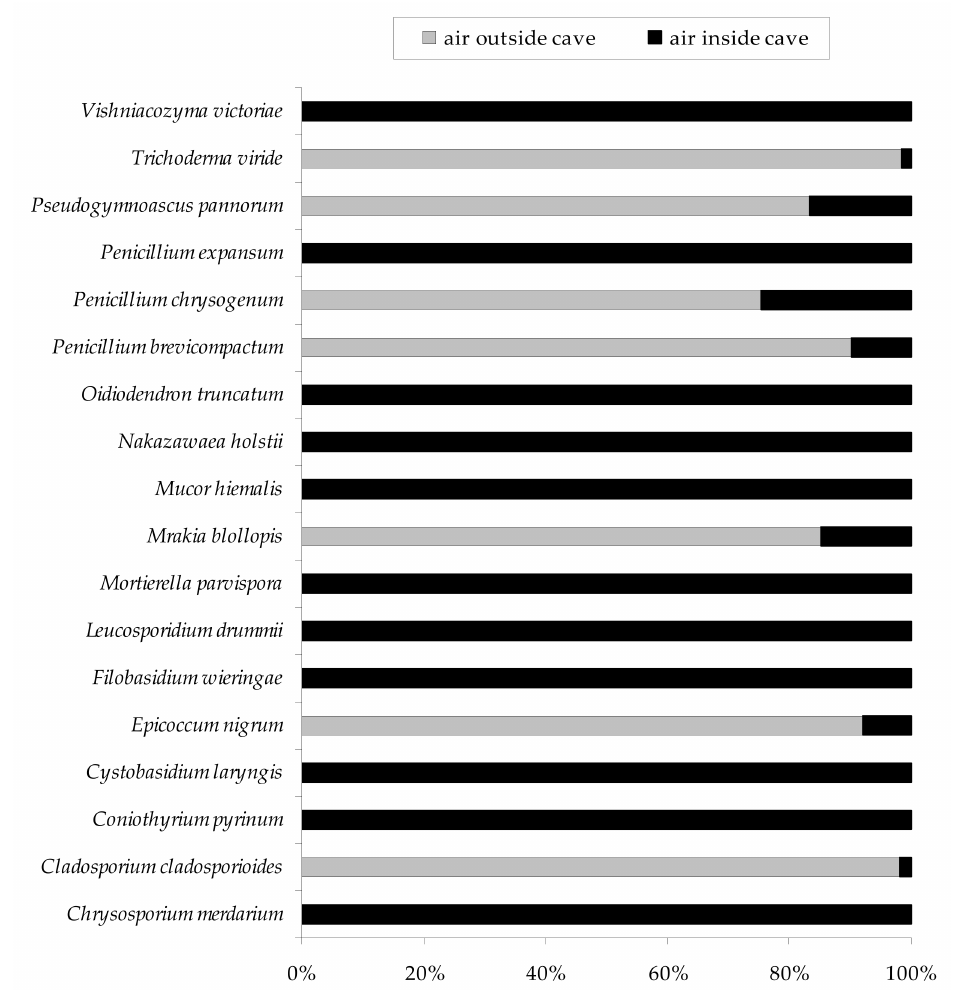
Figure 3. Percentage of each fungal species in the internal and external air samples of the Brestovsk á